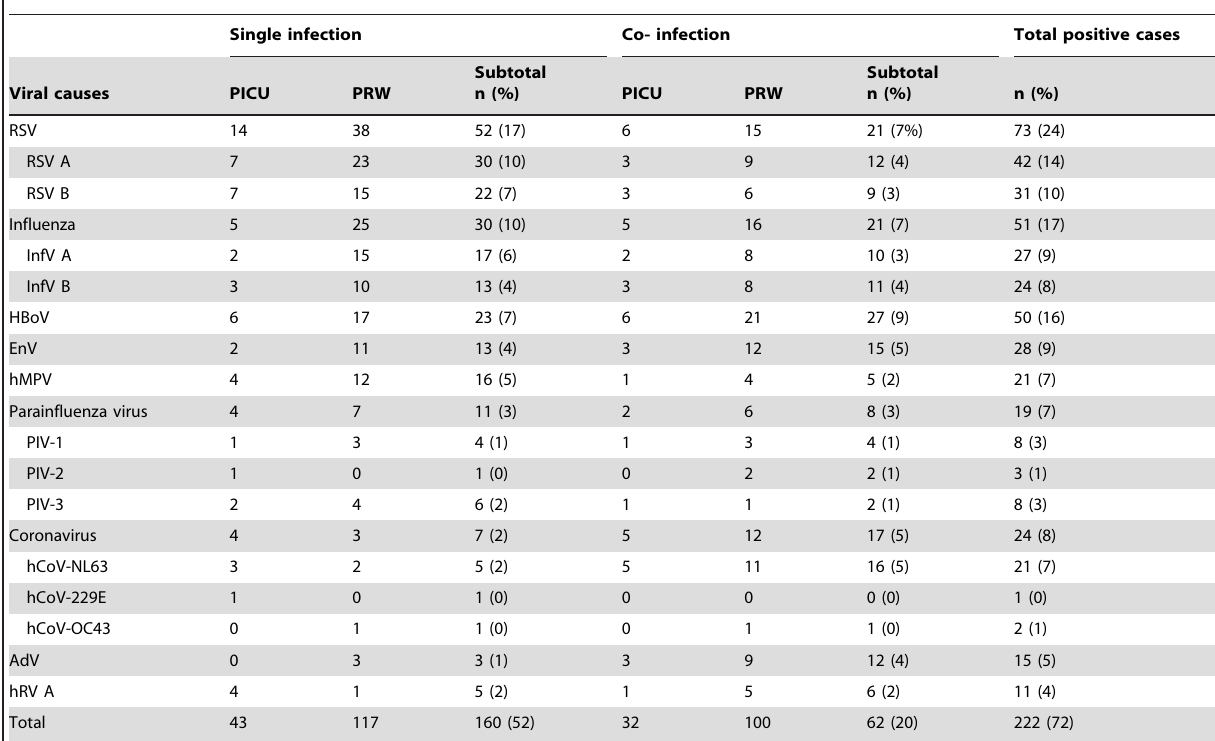
Table 3. Viral etiologies